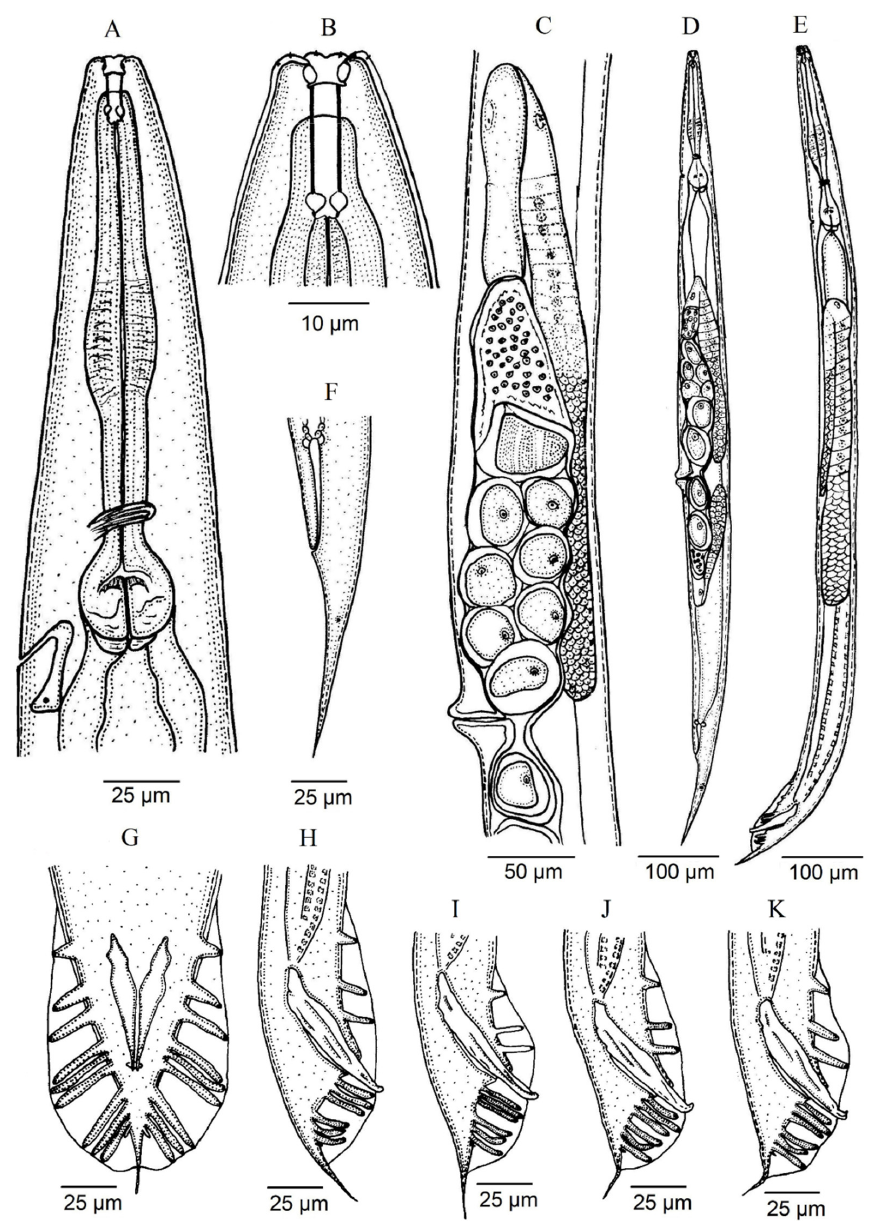
Figure 1. Oscheius siddiqii Tabassum and Shahina, 2010 (line drawing). ( A ): neck; ( B ): anterior end; ( C ): female reproductive system; ( D ): entire female; ( E ): entire male; ( F ): female posterior end; ( G ): male posterior end at ventral view; ( H – K ): male posterior end at lateral view showing variations in spicules.